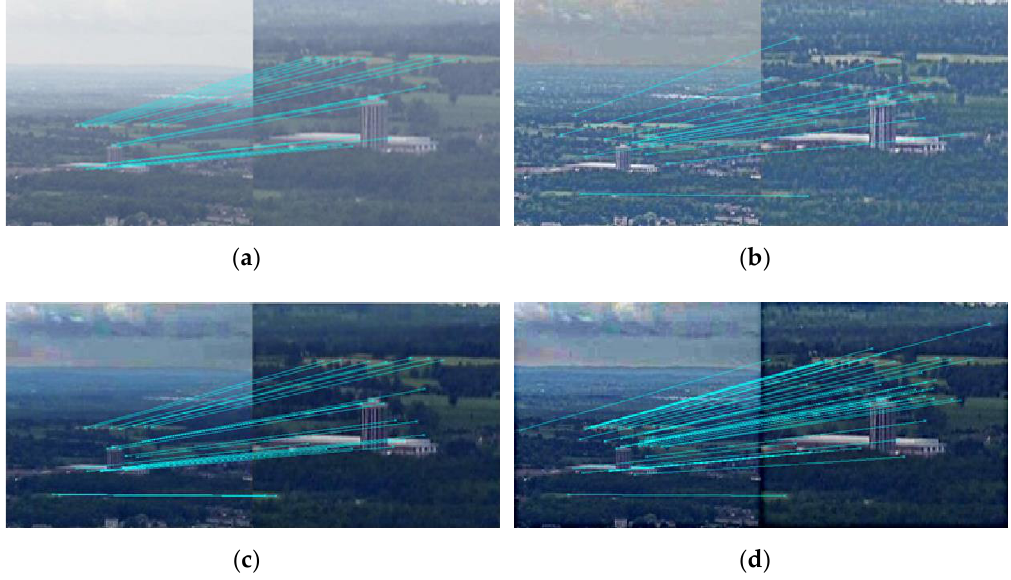
Figure 9. Matching based on C-SIFT: ( a ) original haze images (32 good matches), ( b ) Tarel and Hautiere [35] method (31 good matches) , ( c ) He et al. [40] method (74 good matches), and ( d ) proposed method (85 good matches).